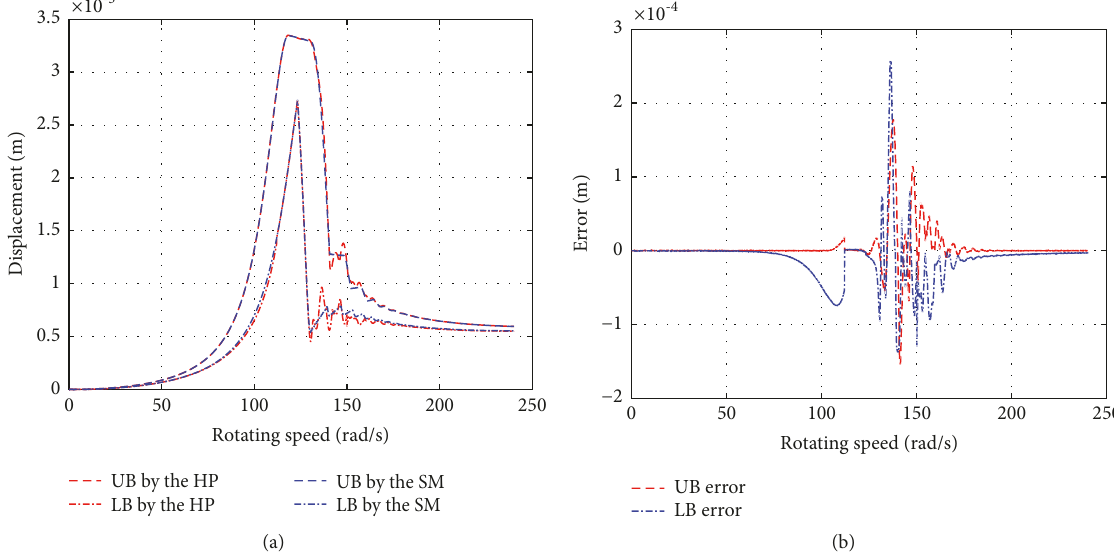
Figure 7: (a) Response ranges with uncertain disk mass calculated by the hybrid procedure and